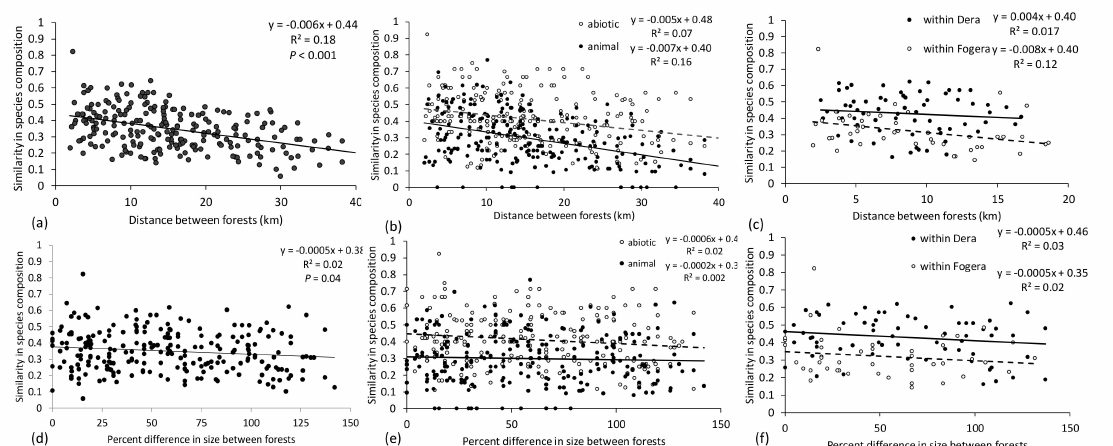
Figure 3. Similarity in woody plant species composition with distance between forests ( a – c ) and percent di ff erence in size between forests ( d – f ) in Montane forests for all plant species ( a , d ), for abiotic-dispersed and animal-dispsered species ( b , e ), and for all species within Woredas ( c , f ). Similarity in species composition was calculated using a Bray–Curtis index on an abundance matrix. Distance between forests was calculated using the great circle distance from the haversine